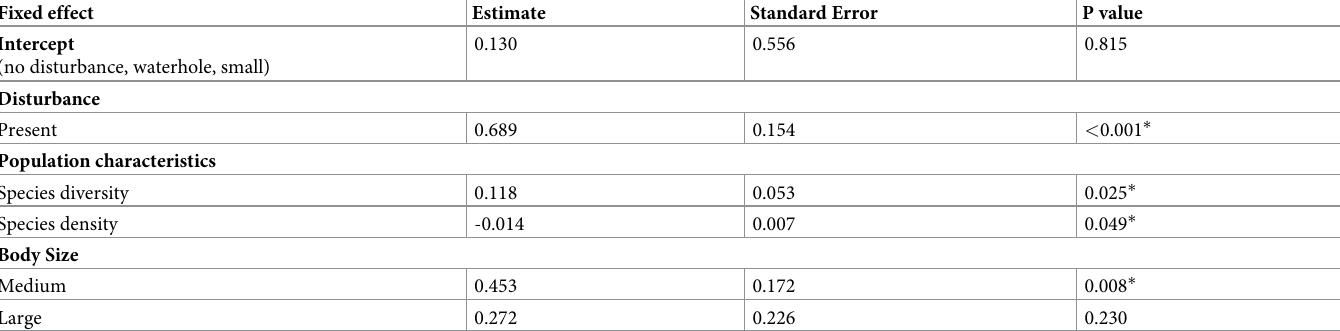
Table 7. Coefficients and P values for the negative binomial GLMM investigating the influence of habitat type, feeding ecology, and body size on the amount of time spent vigilant in the wild.